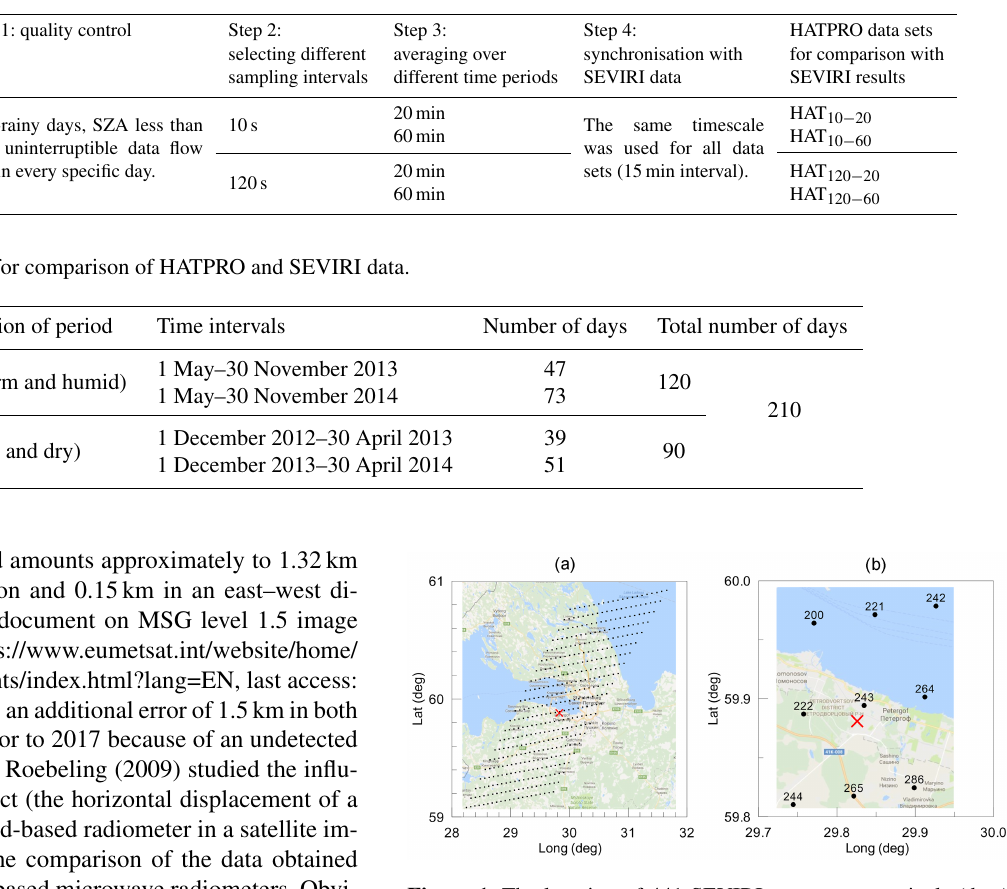
Figure 1. The location of 441 SEVIRI measurement pixels (dots) selected for analysis ( a , large terrain) and the location of the pixels nearest to the radiometric measurement site ( b , small terrain, pixel numbers are shown). The position of the HATPRO radiometer is marked by the red cross. The distance from the centre of pixel 243 to the radiometer is equal to 1.5km. The distance from the centre of pixel 242 to the radiometer is equal to